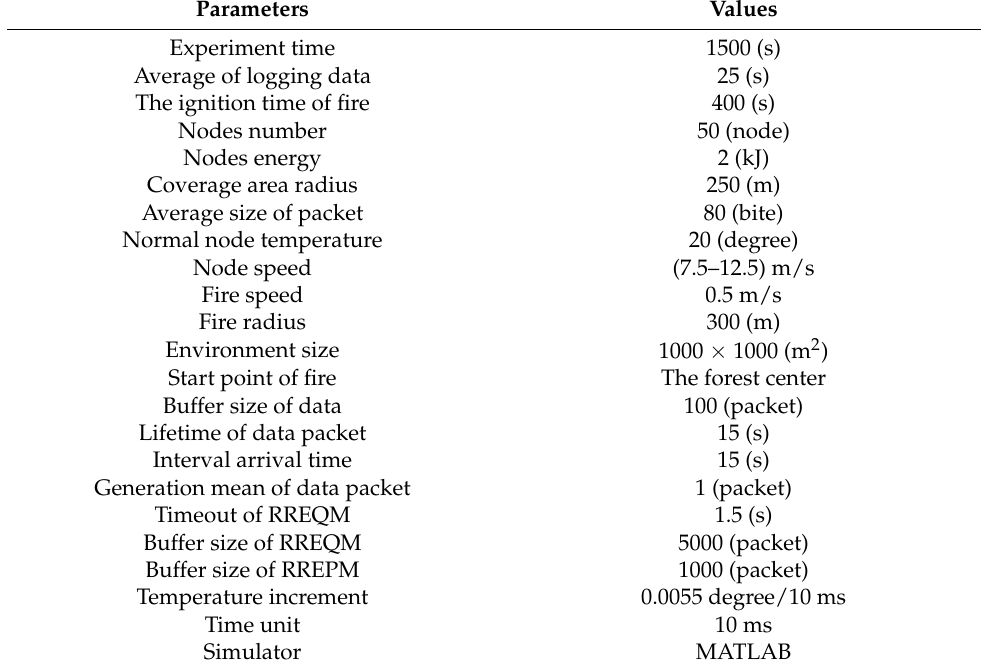
Table 1. Simulation